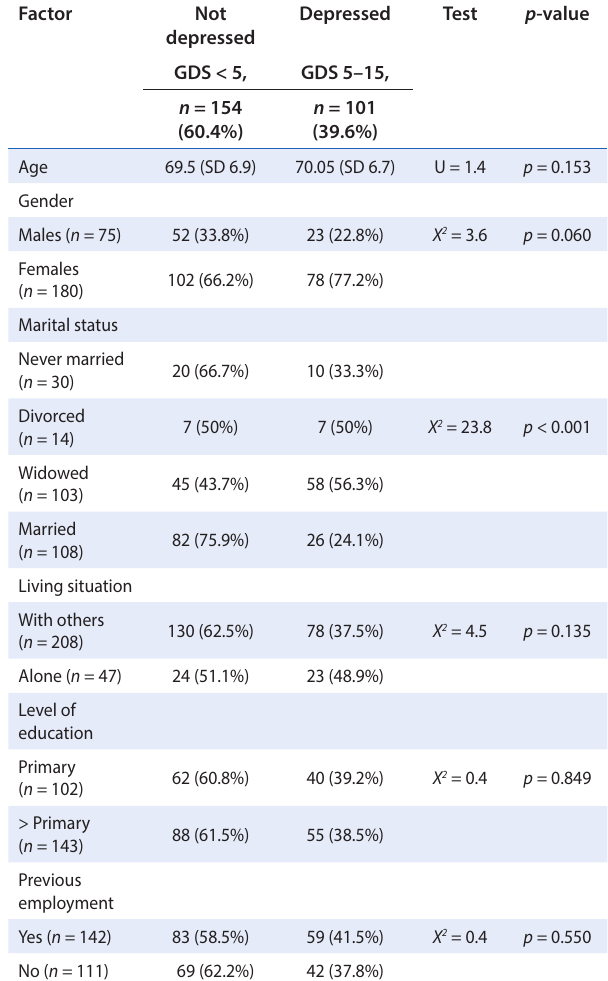
Table 1: Demographic profile of depressed vs. non-depressed participants Factor Not depressed